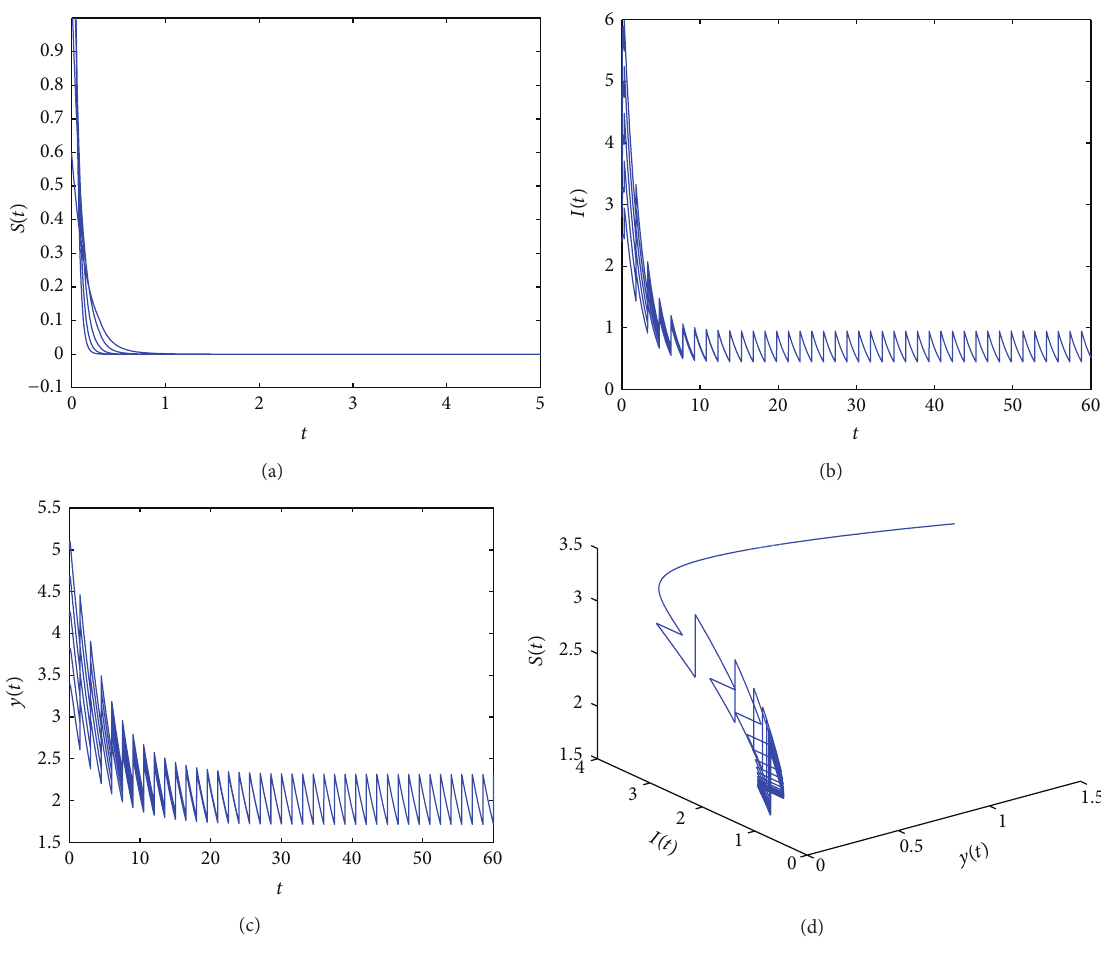
Figure 1: Time sires of 𝑆(𝑡) (a), 𝐼(𝑡) (b), 𝑦(𝑡) (c), and phase portrait (d) in model (1) with the initial values 𝑆(0 + ) = 0.1+0.5𝑘 , 𝐼(0 + ) = 2+0.4𝑘 , and 𝑦(0 + ) = 3 + 0.4𝑘 , 𝑘 = 1, 2, 3, 4,